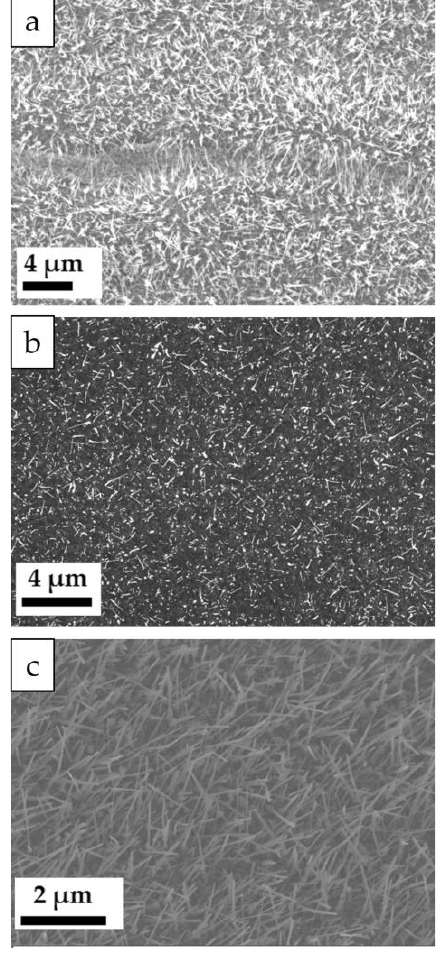
Figure 2. SEM images after heat treatment of three surfaces: copper foil ( a ), vapour deposited copper ( b ), and sputtered copper ( c ) [64].